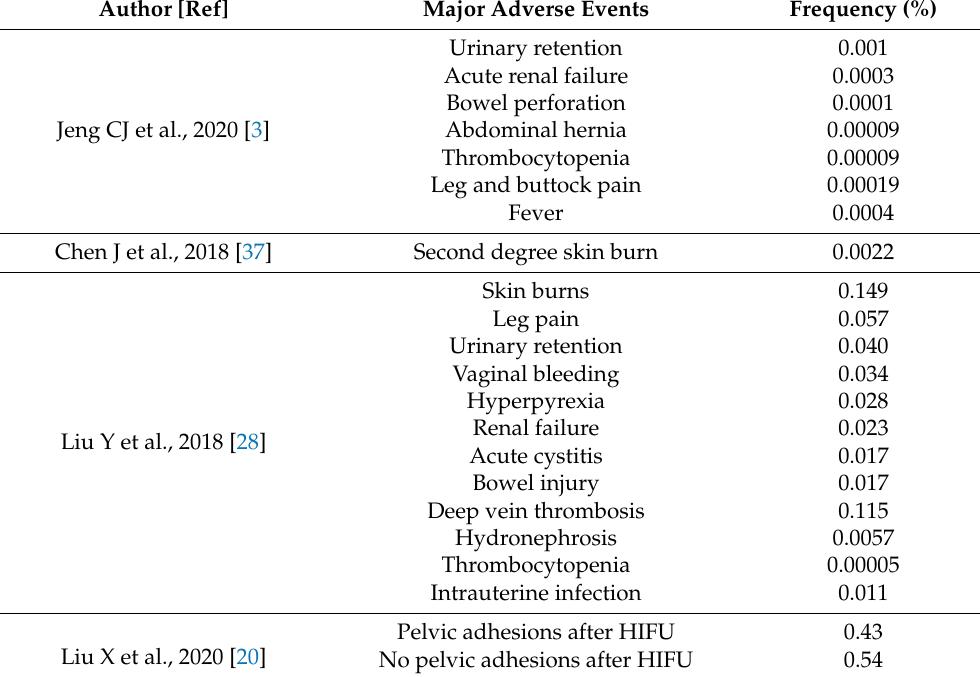
Table 4. Frequency of major adverse events after HIFU therapy reported in clinical